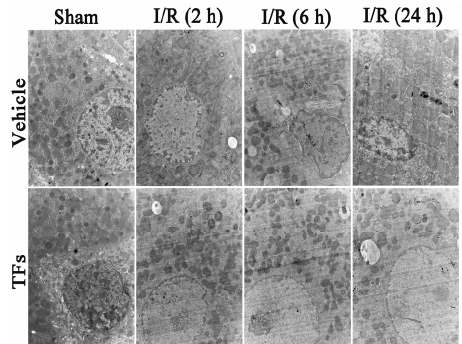
Figure 2. TFs improved I/R ‐ induced cellular structure changes in rats. Effects of TFs on the ultrastructure (15,000× magnification) of hepatic cells after 1 h of ischemia and different times of reperfusion (2 h, 6 h, and 24 h).